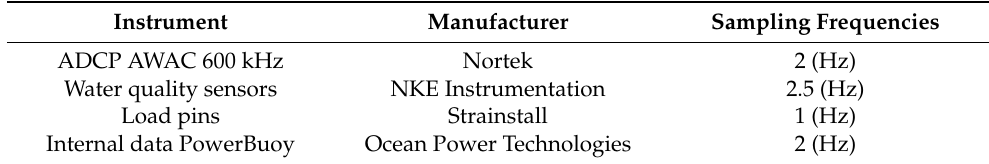
Table 1. Offshore instrumentation and sampling frequencies.